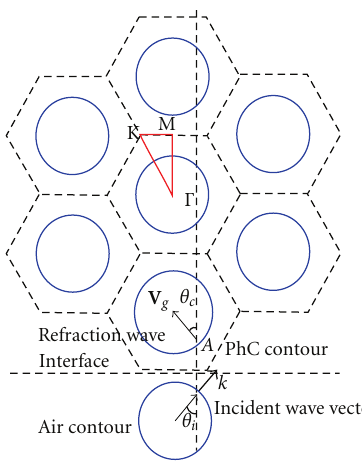
Figure 7: The EFC of frequency ω = 0 . 315(2 πc /a ). The air-PhC interface is normal to the Γ -M direction. θ i is the incident angle of the plane wave. A Bloch wave denoted by A is excited in the PhC. v g is the group velocity of the Bloch wave, which has a refraction angle of θ c against the normal of the interface.